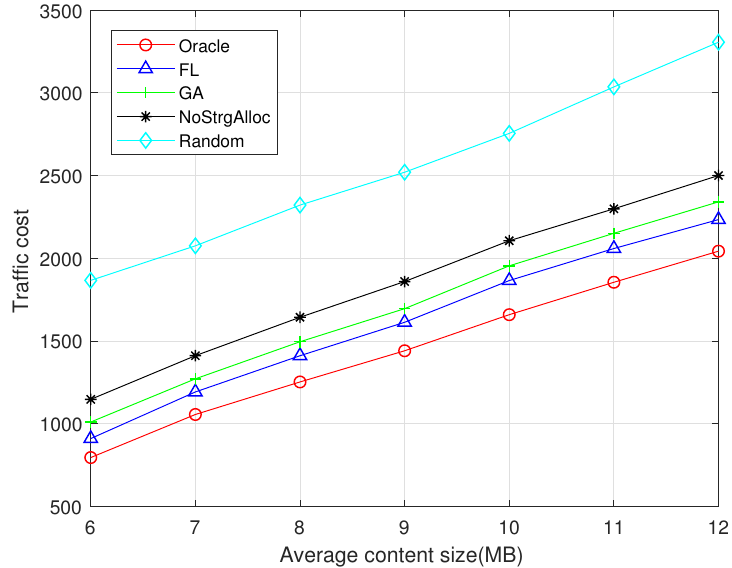
Figure 5. Traffic cost vs average content size (MovieLens 100K).